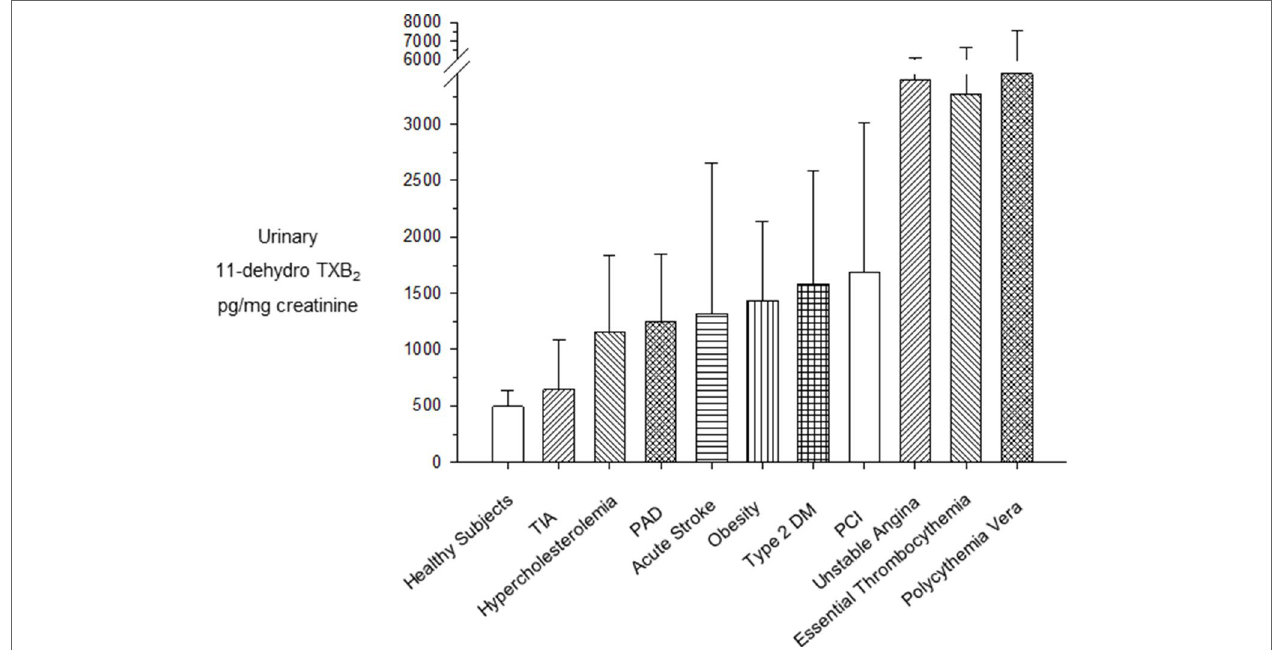
FIGURE 2 | Urinary excretion rates of 11-dehydro-TXB 2 in clinical settings at high cardiovascular risk. Mean (± standard deviation) or median (interquartile range) urinary excretion rates of 11-dehydro-TXB 2 in clinical settings characterized by high cardiovascular risk. PAD, peripheral arterial disease; PCI, percutaneous coronary intervention; T2DM, type 2 diabetes mellitus; TIA, transient ischemic attack. Modified and redrawn from Patrono et al.